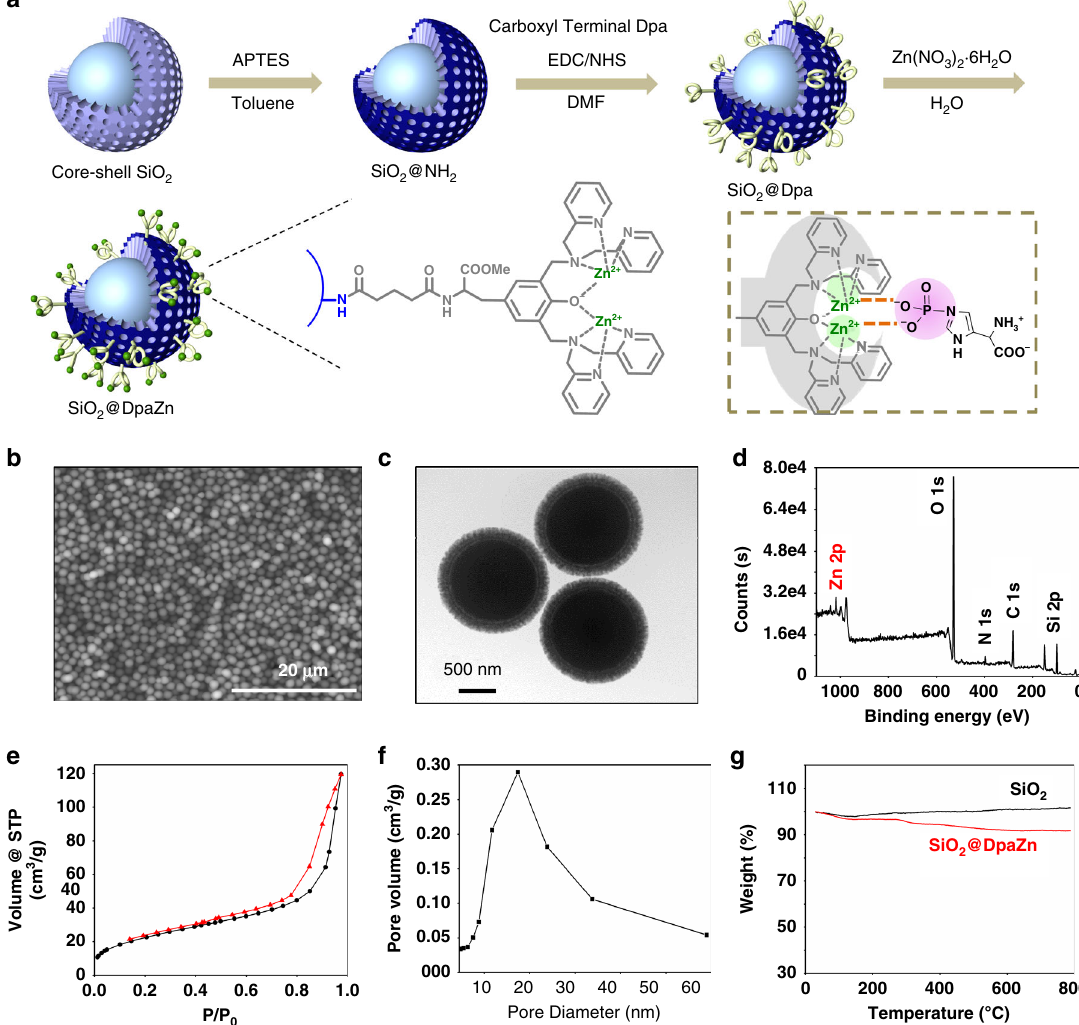
Fig. 2 Preparation and characterization of SiO 2 @DpaZn. a Schematic illustration (inset shows the interaction between DpaZn and pHis), b SEM image, scale 20 μ m, c TEM image, scale 500 nm, d XPS spectrum, e adsorption and desorption curves, and f pore diameter distribution of SiO 2 @DpaZn. g TGA curves of SiO 2 microspheres and SiO 2 @DpaZn. Three different batches SiO 2 @DpaZn were